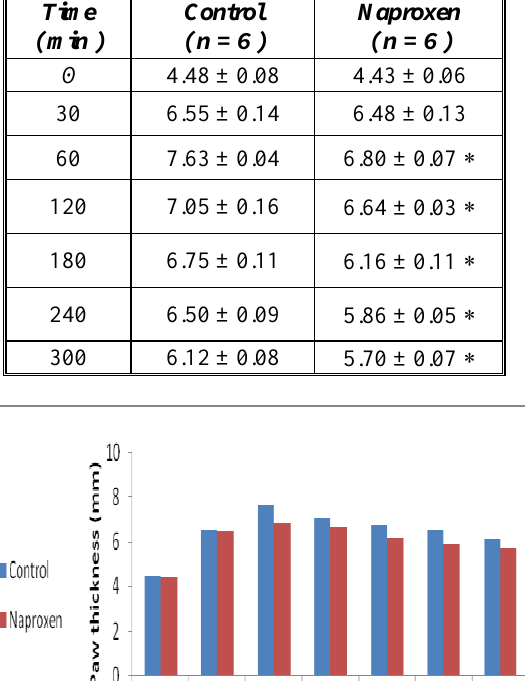
Table 1: Effect of naproxen (reference) and propylene glycol (control) on egg white induced paw edema in rats.